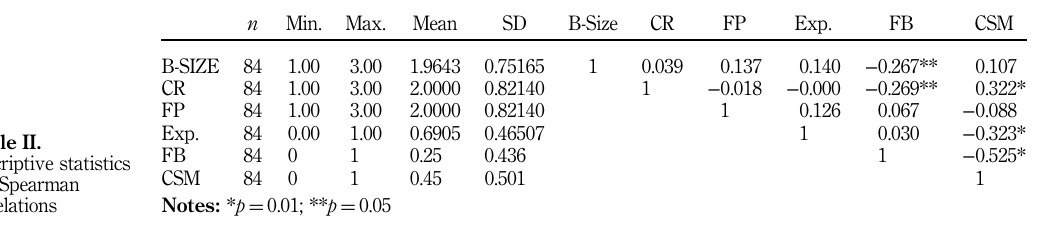
Table II. Descriptive statistics and Spearman